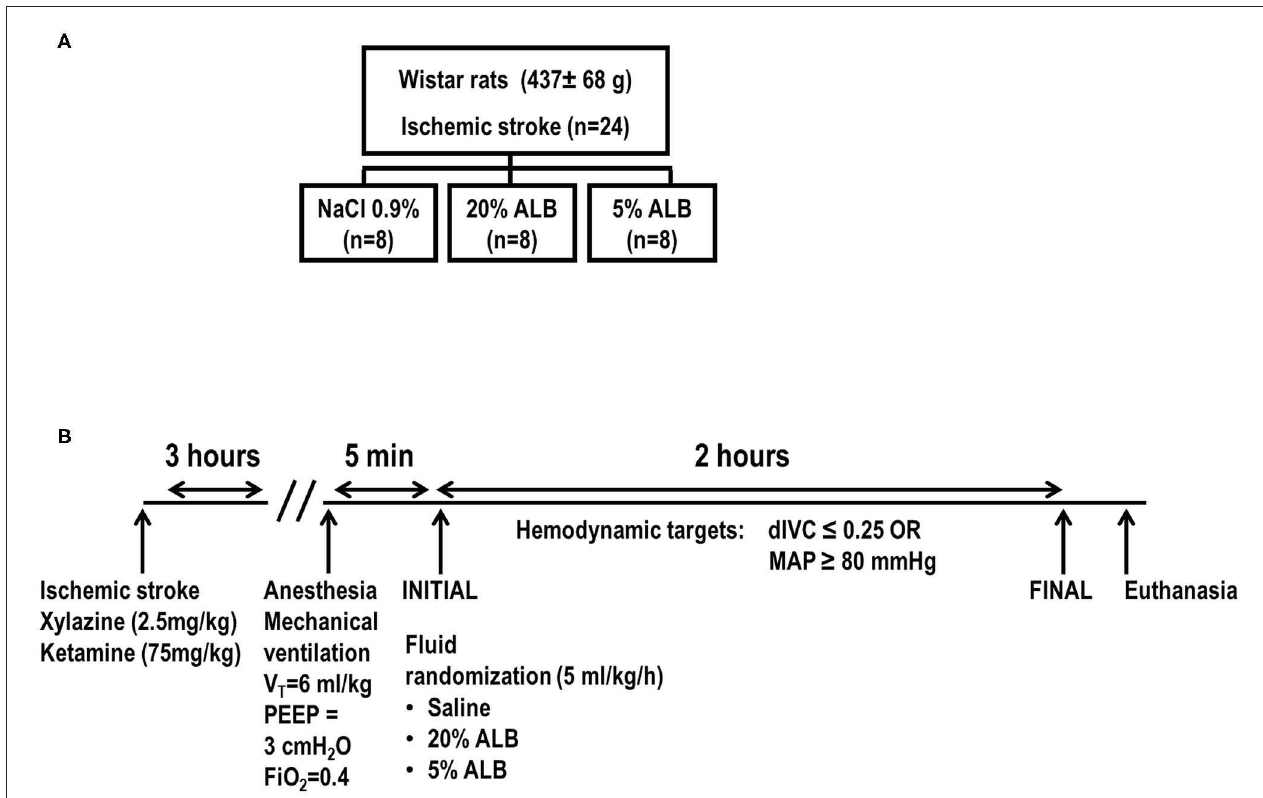
FIGURE 1 | Study randomization (A) and experimental design (B) . Schematic illustration of the model of focal ischemic stroke by craniectomy and thermocoagulation of pial vessels over the right primary sensorimotor cortex is shown in the bottom left. dIVC, distensibility index of inferior vena cava; MAP, mean arterial pressure; V T , tidal volume; PEEP, positive end-expiratory pressure; FiO 2 , inspired fraction of oxygen; 5% ALB, 5% albumin; 20% ALB, 20% albumin.